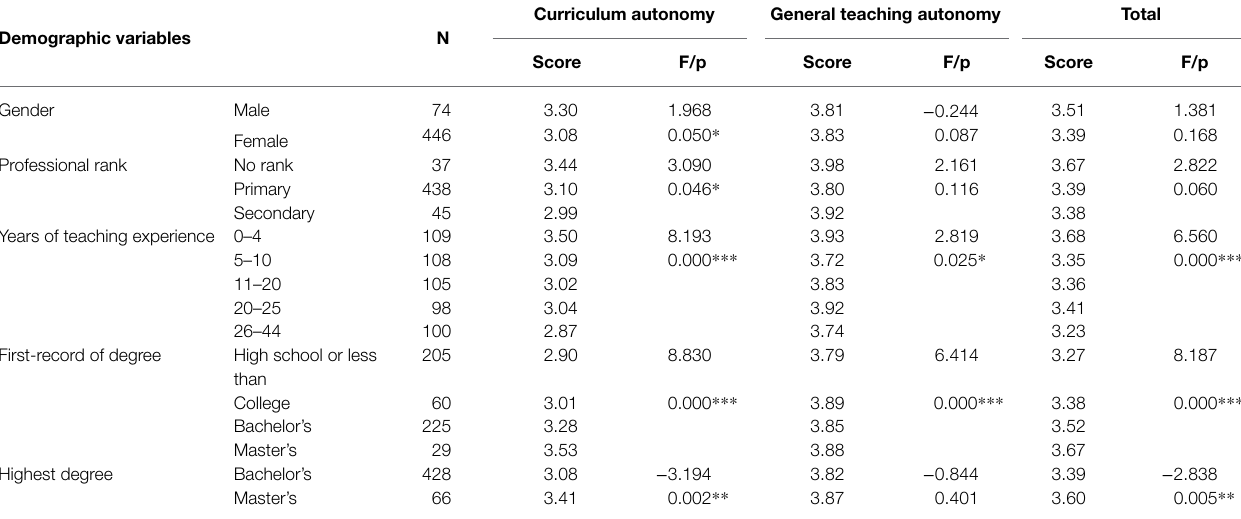
TABLE 4 | Independent sample t -test and ANOVA results of teacher autonomy.